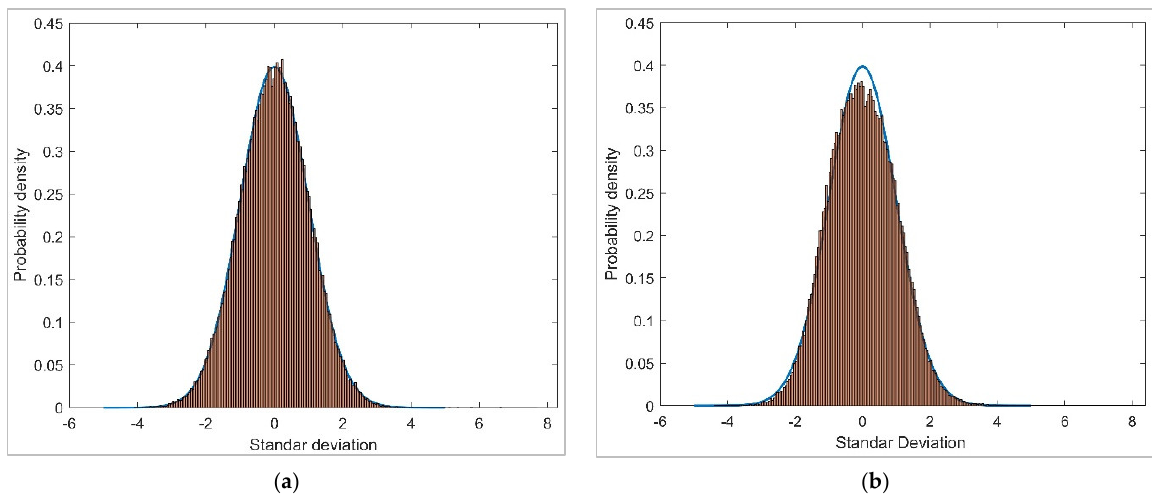
Figure 7. Theoretical normal distribution (blue) and histogram for residual series for all sub-basins: ( a ) Model 1 (maximum temperature) and ( b ) Model 2 (temperature range). The residual series of the MAR(1) for the maximum temperature had a mean near zero, the variance was around 0.85, the skewness coefficient was between −0.245 and 0.026, and the lag-one autocorrelation was around ± 0.01. The skewness coefficient and